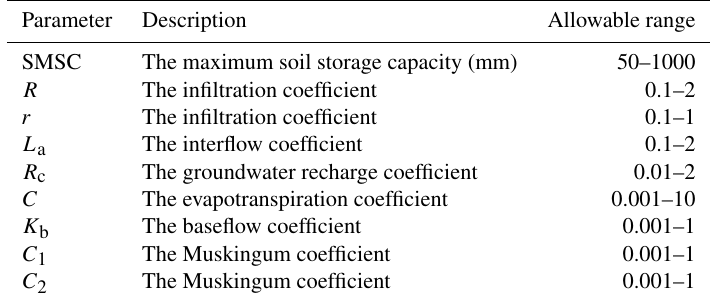
Table 1. Description of HIMS model parameters and allowable ranges.